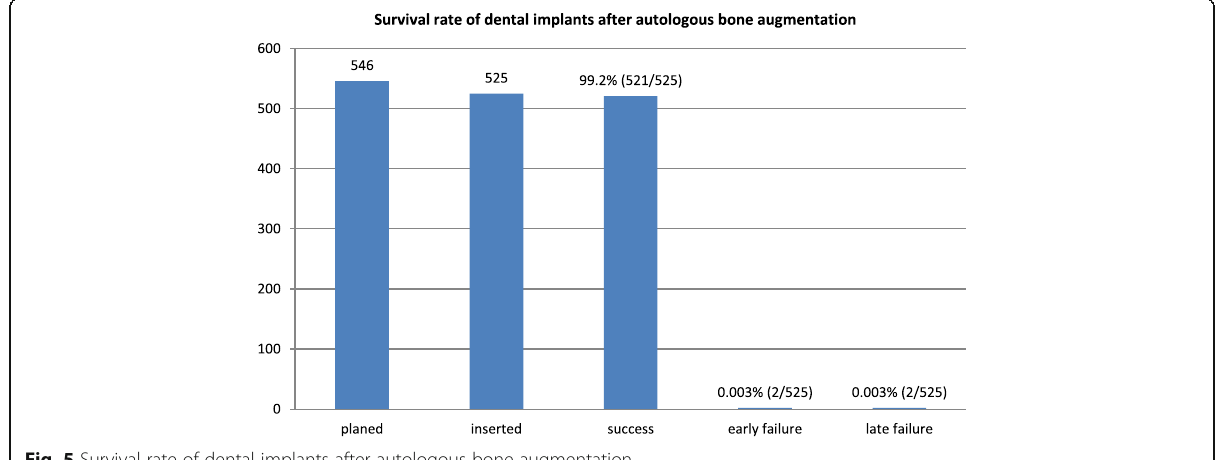
Fig. 5 Survival rate of dental implants after autologous bone